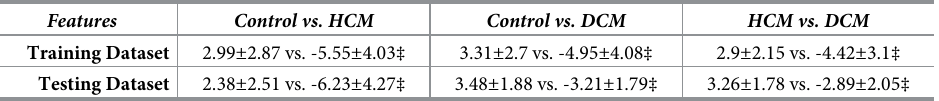
Table 3. Texture index (T x ) values calculated using a linear regression model for binary comparisons (one-vs-one) among 3 cohorts (control, HCM, and DCM) in training and testing